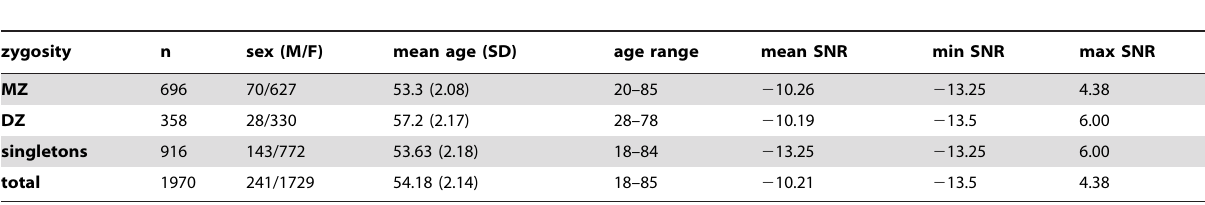
Table 3. Demographic and phenotypic profile of study sample with speech-to-noise ratio data.